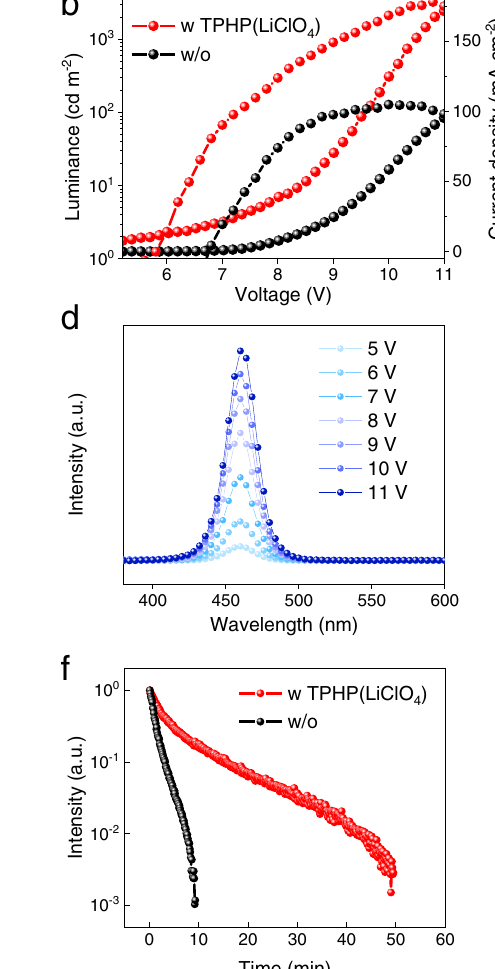
f Comparison of normalized luminance of the QD-LEDs with and without TPHP(LiClO 4 ) as a function of operating time at a constant current density and an initial luminance of ~100cdm − 2 under ambient